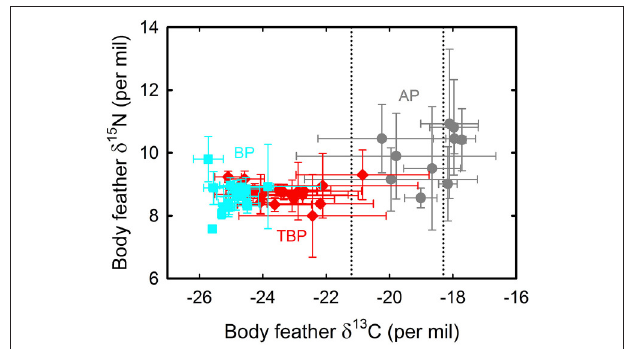
FIGURE 5 | Body feather δ 13 C- and δ 15 N-values of blue petrels (BP, blue) and of thin-billed (TBP, red) and Antarctic (AP, gray) prions that were equipped with miniaturized saltwater immersion geolocators. Values are means ± SD of four feathers per individual bird. Lower and upper control lines refer to the estimated δ 13 C location of the Polar Front and Subtropical Front, respectively (Jaeger et al., 2010b).